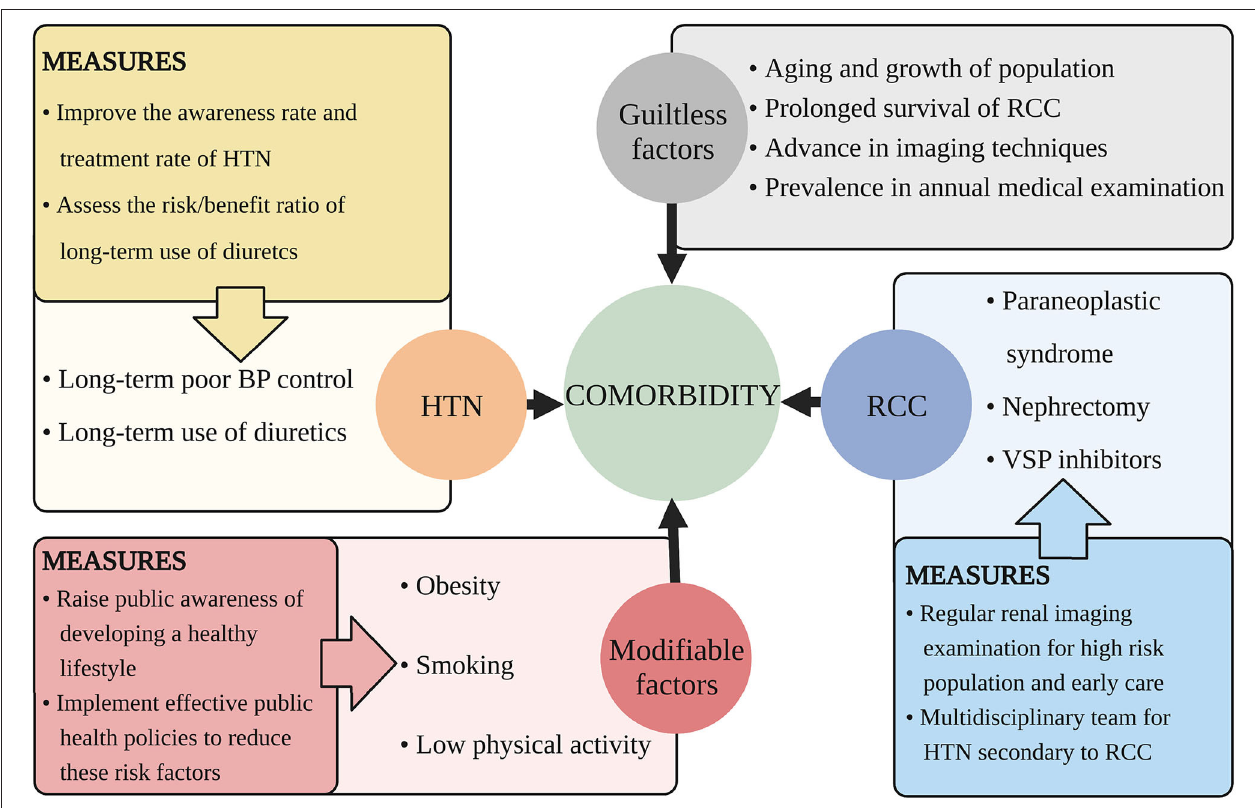
FIGURE 2 | Suggested measures for decreasing the comorbidity of HTN and RCC. This figure illustrates aspects that cause the increasing comorbidity of HTN and RCC and proposes related measures. HTN, hypertension; RCC, renal cell carcinoma; BP, blood pressure; VSP, vascular endothelial growth factor signaling